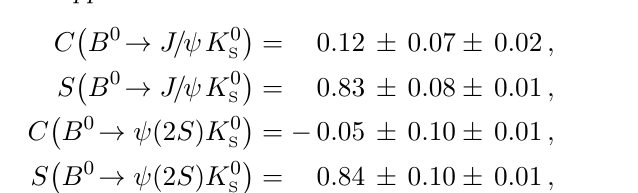
Table 3 . Systematic uncertainties for the CP -violation observables S and C . corresponding to 3 fb (cid:0) 1 of pp collision data results in the CP -violation